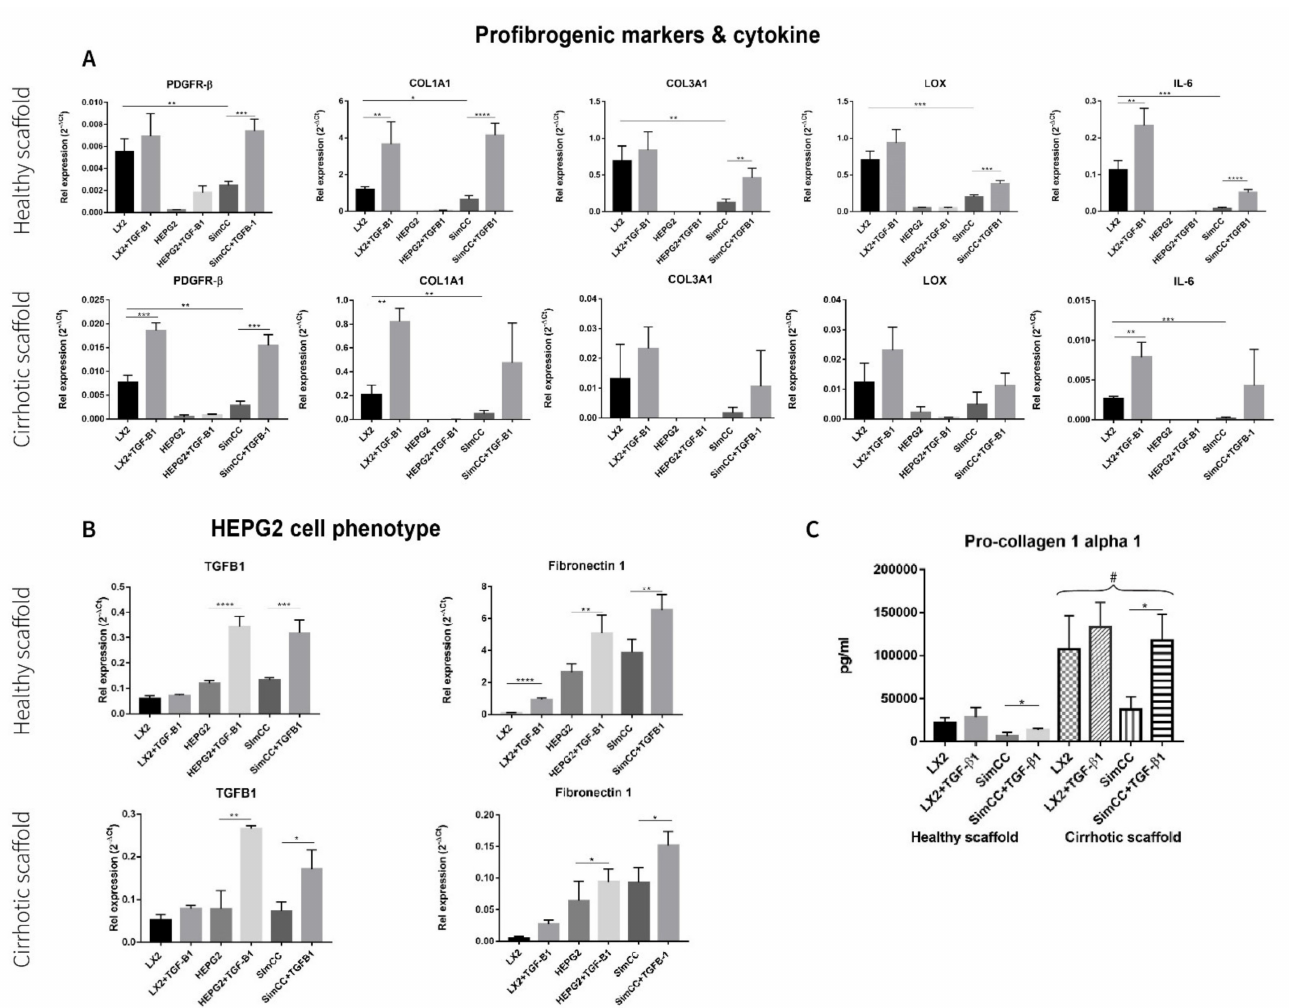
Figure 3. Response to TGF- β 1 exposure of LX2 and HepG2 cells mono-culture and co-culture in 3D healthy and cirrhotic ECM liver scaffolds. ( A ) Gene expression related to pro-fibrogenesis and cytokines in different culture conditions tested. ( B ) Changes in HepG2 gene expression related with hepatocellular carcinoma cell progression, n = 4 scaffolds per condition. ( C ) LX2 cells pro-collagen 1a1 secretion as single culture and simultaneously co-cultured (CC) with HepG2 cells, with or without TGF- β 1 (5 ng/mL) exposure (# = p ≤ 0.01 for each condition in 3D healthy scaffold versus 3D cirrhotic scaffold) (* p ≤ 0.05, ** p ≤ 0.01, *** p ≤ 0.001, and **** p ≤